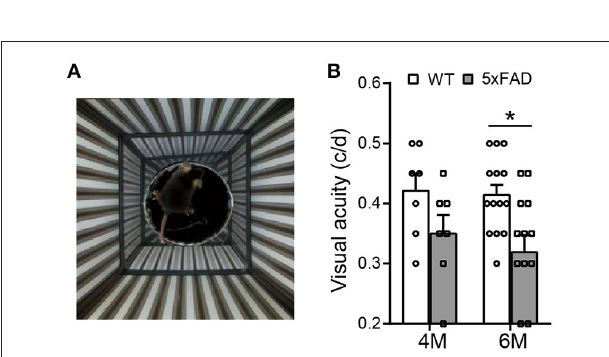
FIGURE 3 | The visual acuity is impaired in 5xFAD mice at 6 months. (A) Illustration of the optokinetic system that measures the mouse visual acuity. Visual acuity is the maximum spatial frequency of the moving gratings that a mouse can track with its head movement. (B) Scattered plot of the visual acuity of 5xFAD and WT at 4 and 6 months. The visual acuity of 5xFAD was lower than that of WT both at 4 months and at 6 months, and the difference reached significance at 6 months. Data shown as mean ± SEM. * p < 0.05, two-way ANOVA.